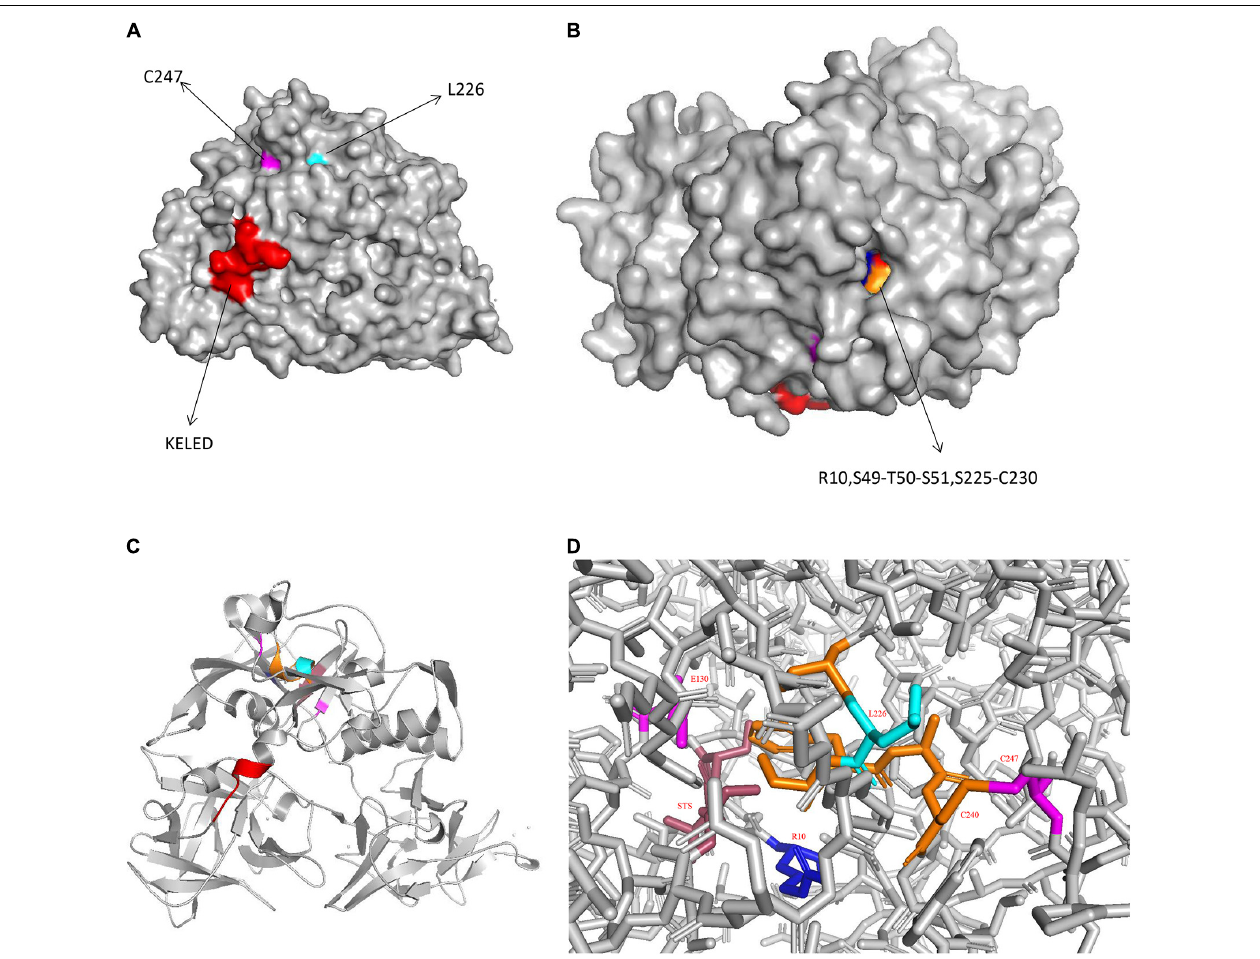
FIGURE 1 | Structure of CARDS TX. (A) Surface representation of CARDS TX with its signature motifs. (B) Invaginated expression sites of CARDS TX. (C) Cartoon representation of CARDS TX. (D) The stick model of CARDS TX. (Red: KELED motif; blue: R10; magenta: E130 and C247; orange: S225-C230; cyan: L226).